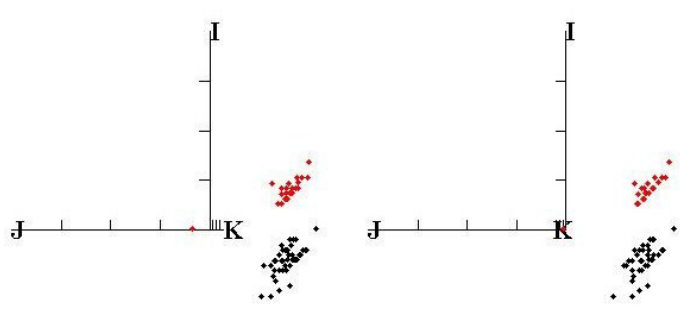
Figure 2a. Stereo-pair scatter plot (with included 95% distribution ellipsoids) of P1: 50 auto-keratometric measurements taken before (black data points) and P2: 50 auto- keratometric measurements taken after (red data points) three hours of PMMA contact lens wear. The origin of the scatter plot is 41.85 I D.